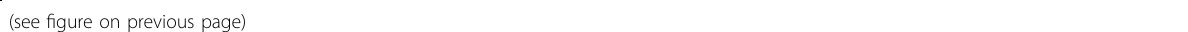
Fig. 5 CAPN2 is responsible for the oncogenic function of hnRNPK/ LINC00263 /miR-147a. a By comparing RNA sequencing data and miR-147a predicted target genes (TargetScan v7), eight genes were selected as putative targets of hnRNPK/ LINC00263 /miR-147a. b To check whether the interaction of hnRNPK with CAPN2 mRNA is required for the regulation of its expression, an RNP-IP experiment was performed. The levels of CAPN2 mRNA and LINC00263 in each IP material were determined by RT-qPCR analysis. c – g Following transfection of HeLa cells with pre-miR-147a (for overexpression, c , e , and g ) or anti-miR-147a (for inhibition, d and f ), the levels of CAPN2 protein and mRNA were determined by Western blot and RT-qPCR analyses, respectively. To examine whether miR-147a directly binds to the 3 ′ UTR of CAPN2 mRNA, Ago2 RNP-IP ( e , f ) and luciferase reporter assay ( g ) were performed. Detailed information of luciferase reporter vector is presented in Supplementary Fig. 7c. h Protein and mRNA expression of CAPN2 in hnRNPK- and LINC00263 -silenced cells were determined by Western blot and RT-qPCR analyses, respectively. i To examine whether knockdown of hnRNPK or LINC00263 in fl uences the interaction between miR-147a and CAPN2 mRNA, Ago2 RNP-IP assay was performed as described in “ Materials and methods ” . j – m The effect of CAPN2 silencing on malignant phenotypes including invasiveness ( k ), proliferation ( l ), and clonogenicity ( m ) were investigated. The ef fi ciency of CAPN2 silencing was determined by Western blot analysis ( j ). Bars on microscopic images represent 100 μ m. Statistical analyses were performed using the Student ’ s t test using three independent experiments (* p < 0.05). All data represent mean ± standard variation